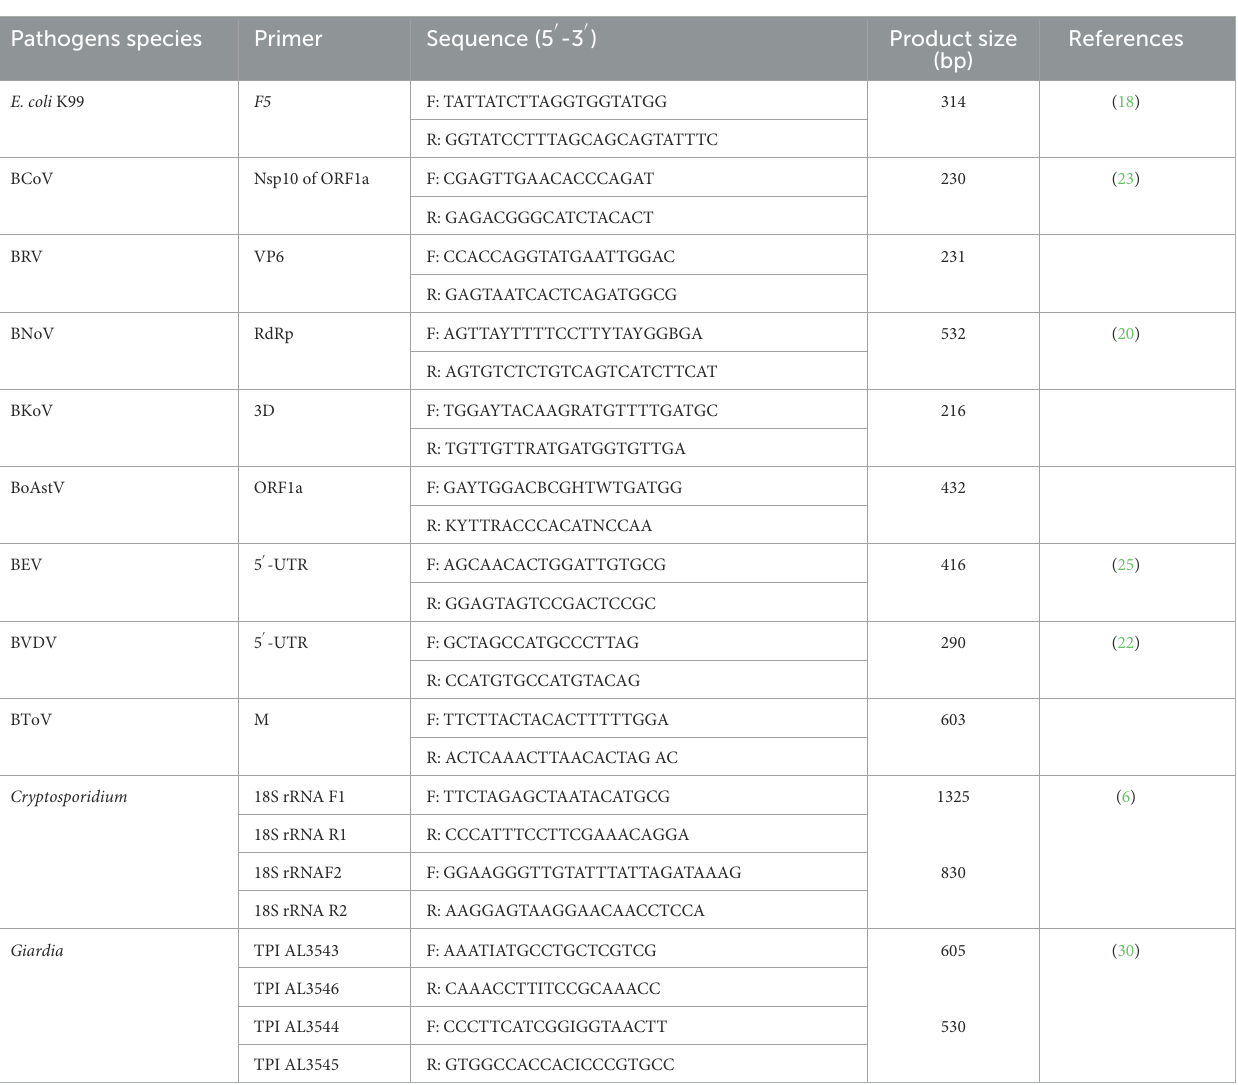
TABLE 2 Primers used for